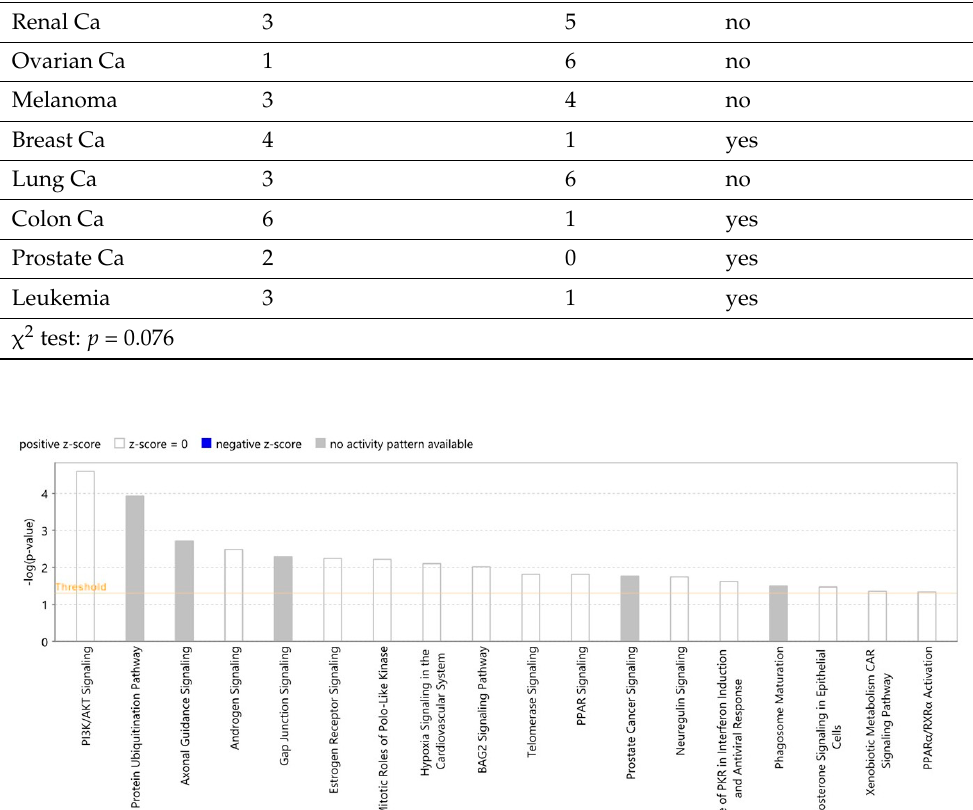
Figure 10. Network analysis using the proteomic data of 40 proteins in a panel of 55 NCT tumor lines and IPA™. 2.9. Drug Resistance Profiling of Gedunin Finally, we were interested in whether gedunin is involved in the drug resistance phenotypes not only of P-glycoprotein but also of other ABC-transporters (ABCB5, ABCC1, and ABCG2), as well as drug resistance mechanisms apart from ABC- transporters, such as the oncogene EGFR, the tumor suppressors TP53 and WT1, the heat shock protein HSP90, glutathione S-transferase π , and the proliferation rate of the cell lines (Table 5). We did not observe statistically significant correlations of the log 10 IC 50 values for gedunin and any of the resistance parameters except for EGFR expression. This indicates that the overexpression of this oncogene was associated with resistance to